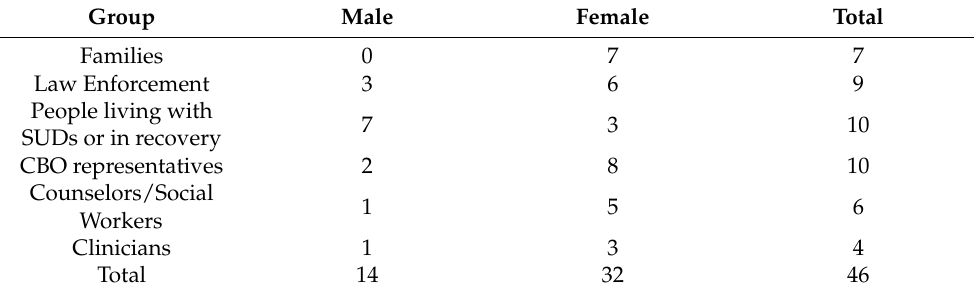
Table 1. Distribution of Participants in Focus Group